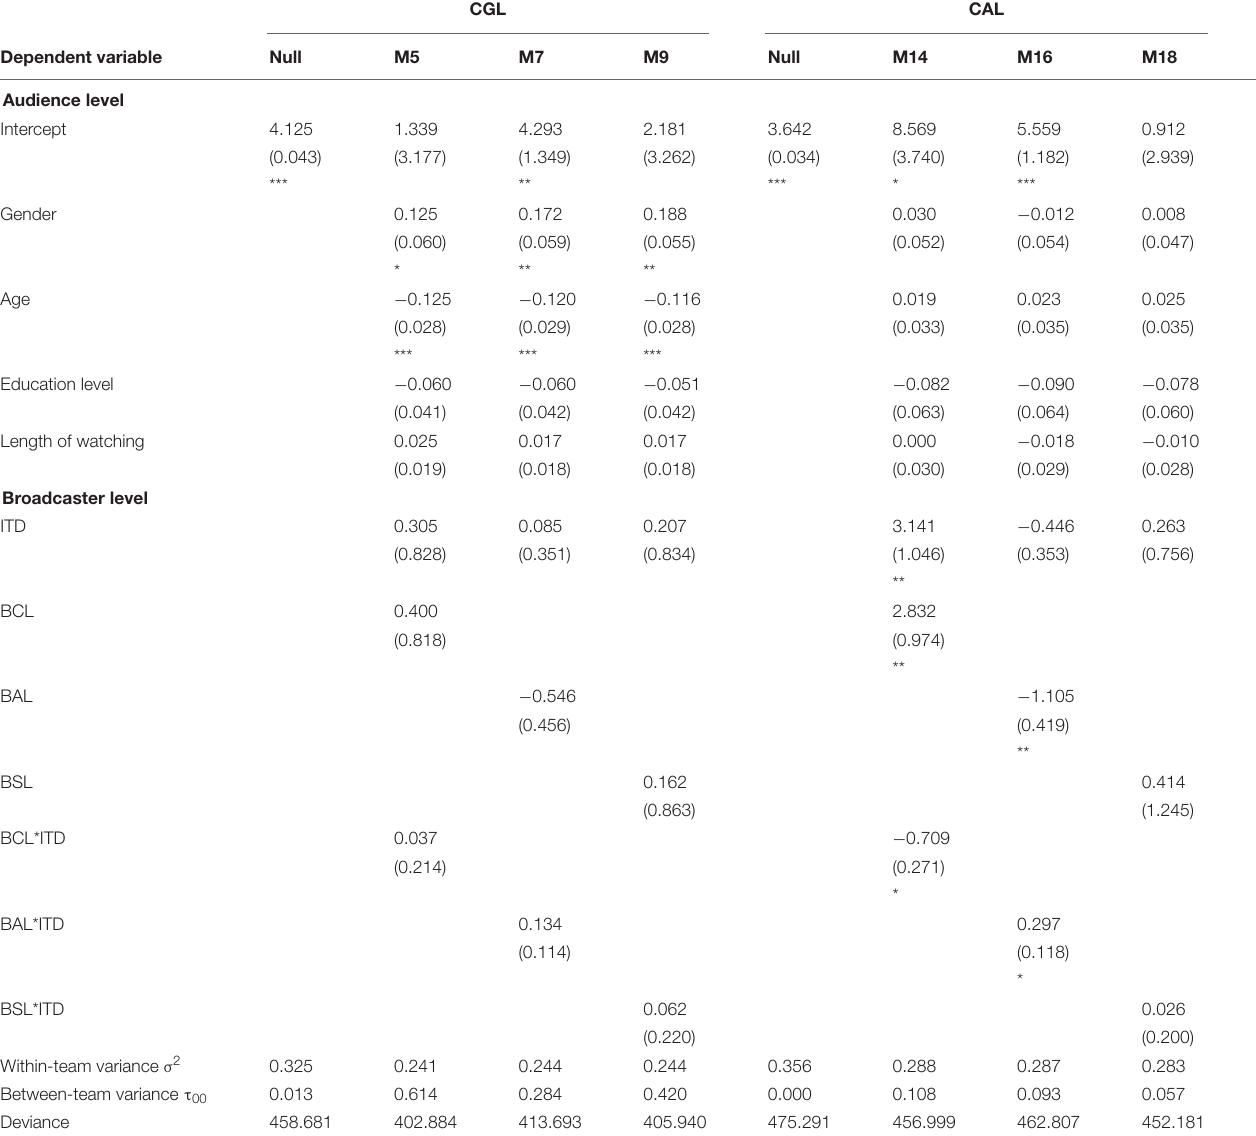
TABLE 7 | The HLM results of broadcaster leadership, ITD and loyalty. CGL